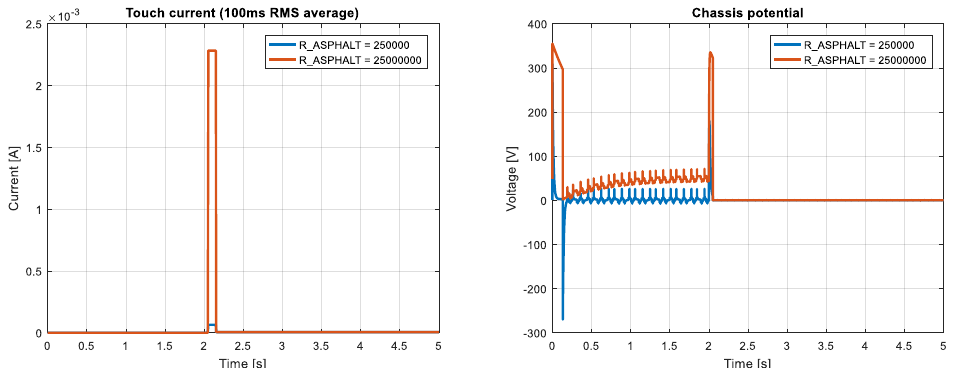
Figure 5. Touch current (100 ms RMS average) ( left ) and chassis potential ( right ) under negative rail connection loss (at t = 2s) and touch event (at t = 2.05s).